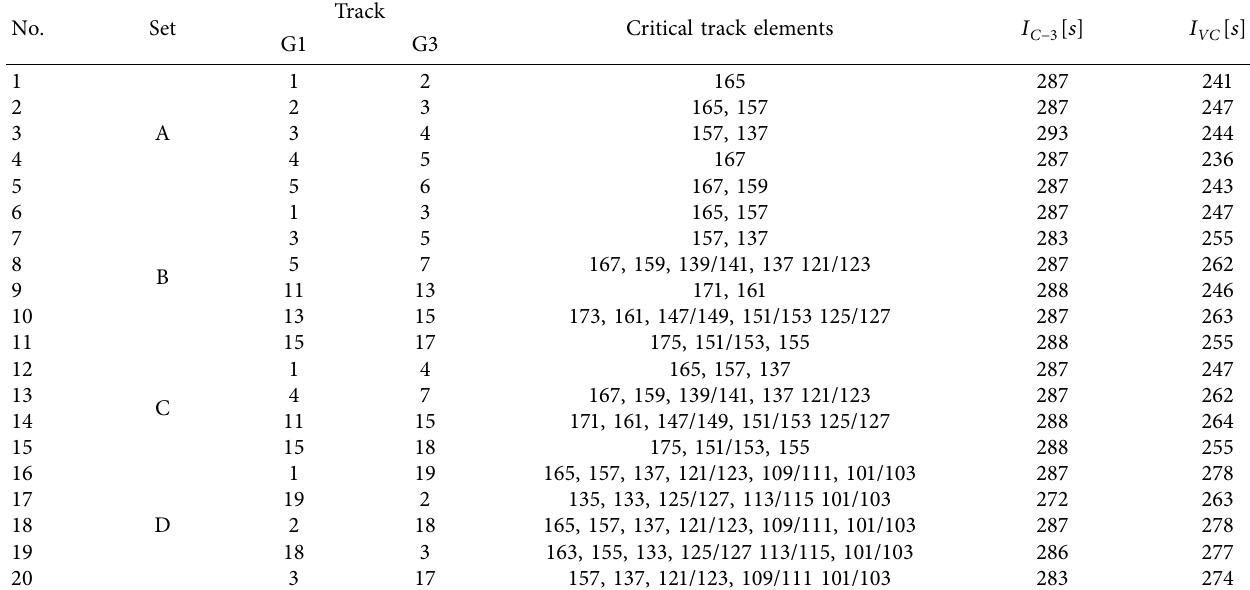
Table 10: Outcomes of train headways in scenario